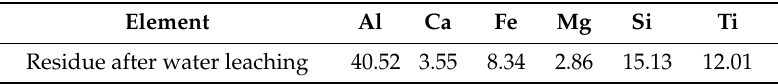
Table 1. The chemical composition of black dross after water leaching. (unit: wt